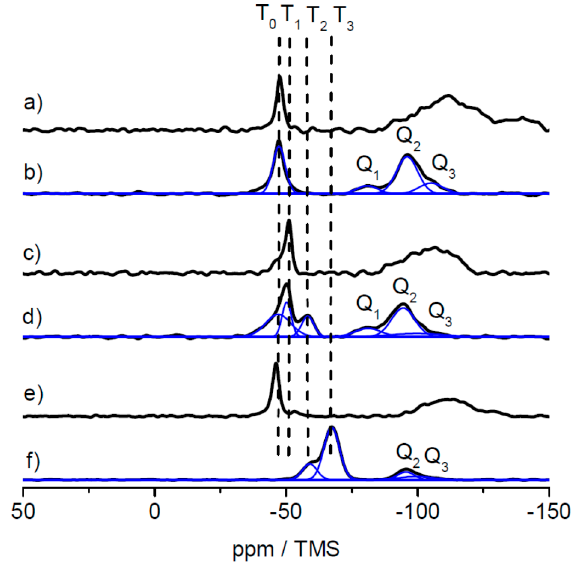
Figure 5. 29 Si static spectra of the free linkers MPSEt ( a ), MPSIsoprop ( c ) and MPSMeEt ( e ), and corresponding 29 Si CP MAS spectra of the lyophilized powder samples prepared with these linkers ( b , d , f ). Note: the broad signal in the high field region of the static spectra refers to the rotor insert that was employed to handle the liquid linkers for static measurements with the solid-state NMR probe. The spectra of the lyophilized powder samples were deconvoluted to ease the signal assignment to different structural elements.